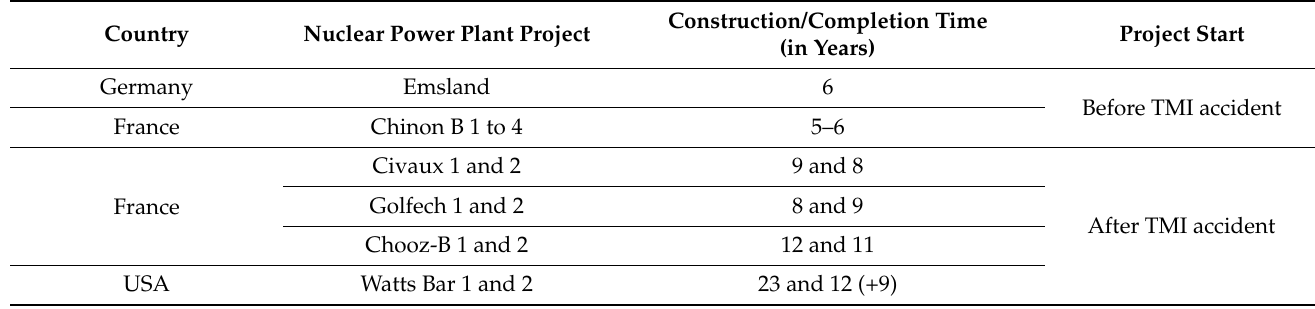
Table 1. Construction time of various nuclear power plant projects initiated before and after the TMI accident [27].